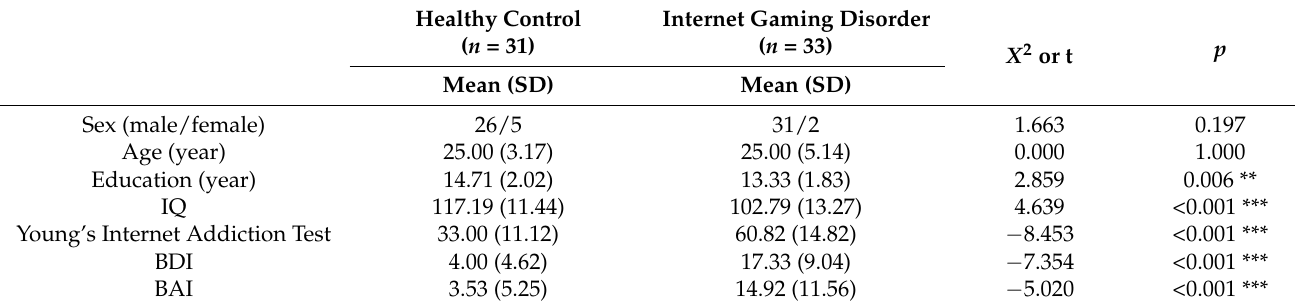
Table 1. No between-group differences in sex or age were observed. Significant group differences were observed in education, IQ, Y-IAT, BDI, and BAI scores. Compared with HCs, patients with IGD reported lower education years (t(62) = 2.859, p < 0.01) and IQ (t(62) = 4.639, p < 0.001) and higher Y-IAT (t(62) = − 8.453, p < 0.001), BDI (t(62) = − 7.354, Table 1. Demographic and clinical characteristics of study